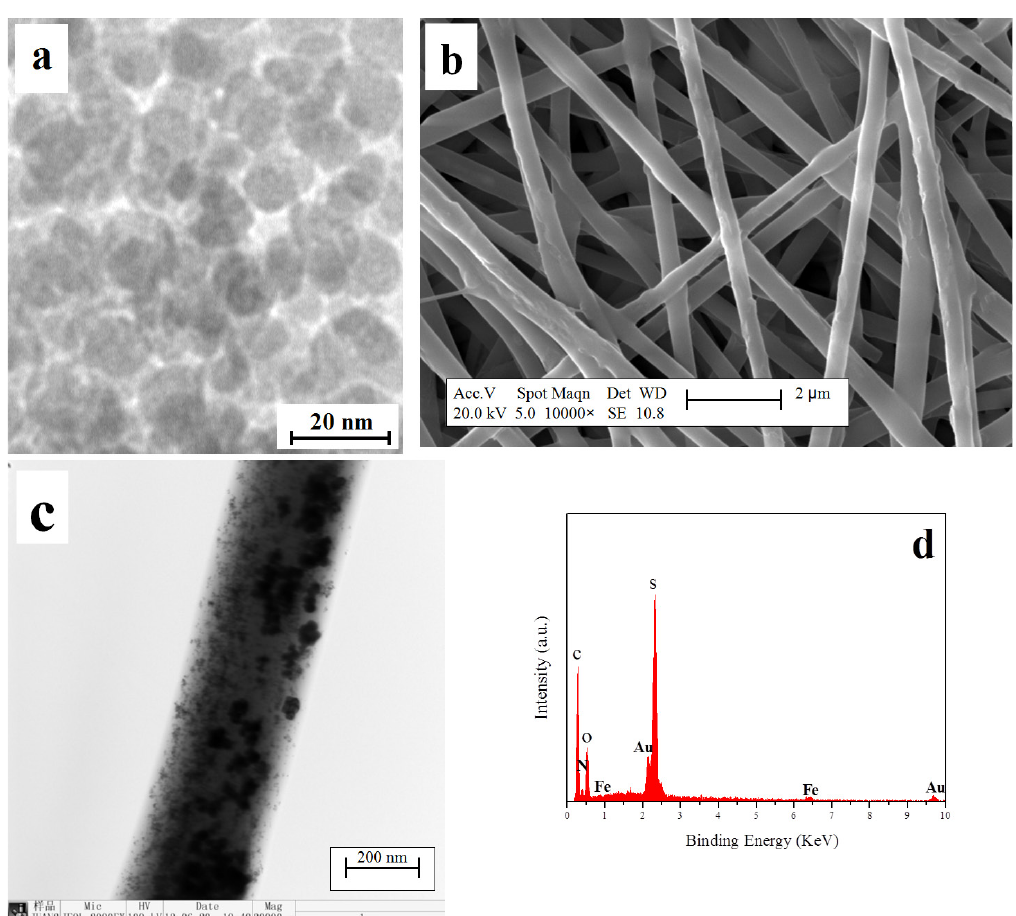
Fig. 2 TEM image (a) of Fe